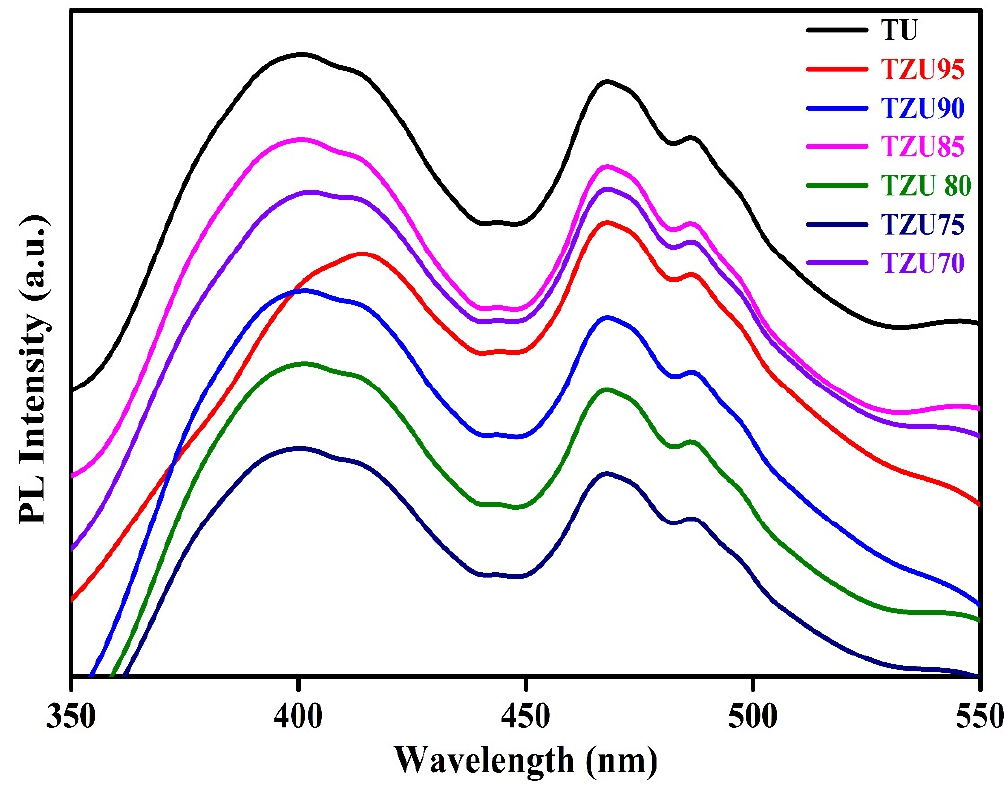
Figure 5. Photoluminescence (PL) spectra of TU, ZU, TZU95, TZU90, TZU85, TZU80, TZU75 and TZU70.